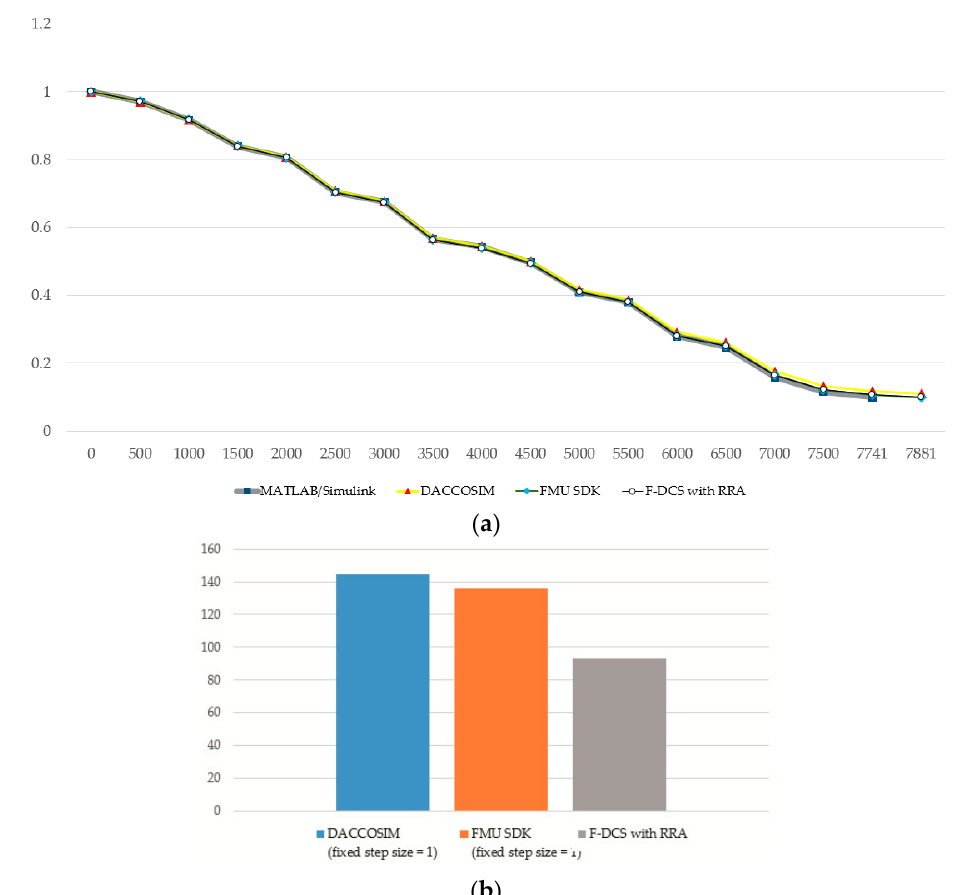
Figure 15. Results of model validation; ( a ) result of battery SOC, ( b ) average total simulation time (sec). Table 3. Average zero crossing point error (ZCPE) of simulation values.